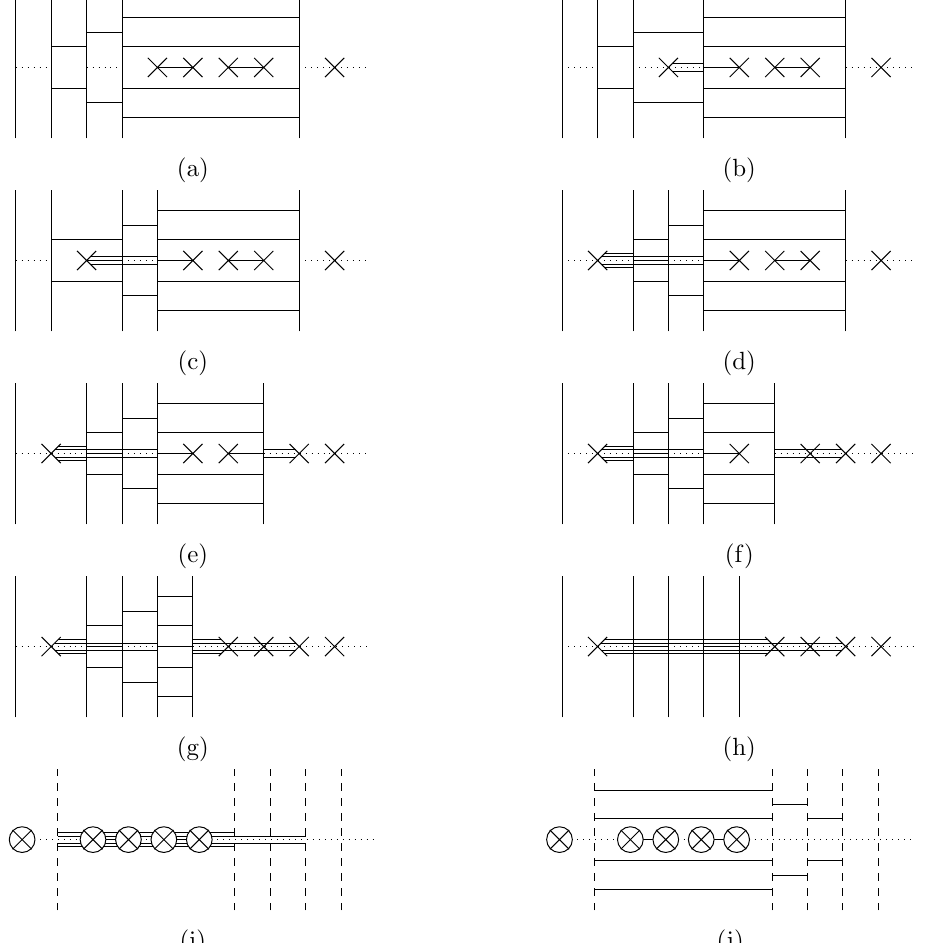
Figure 31. Higgsing of the maximal model of sp (2). The parameters de(cid:12)ning this model are n s = n d = 5, ~ l d = (5 ; 3 ; 5 ; 3 ; 5), ~ l s = (1 ; 1 ; 1 ; 1 ; 1) and rightmost orientifold plane g O 3 + . The interval numbers of the half NS5-branes in (j), after performing a collapse transition, are ~ k s = (0 ; 1 ; 1 ; 1 ; 1). This gives (cid:21) t = (1 4 ), hence (cid:21) = (4) can be obtained in this way.